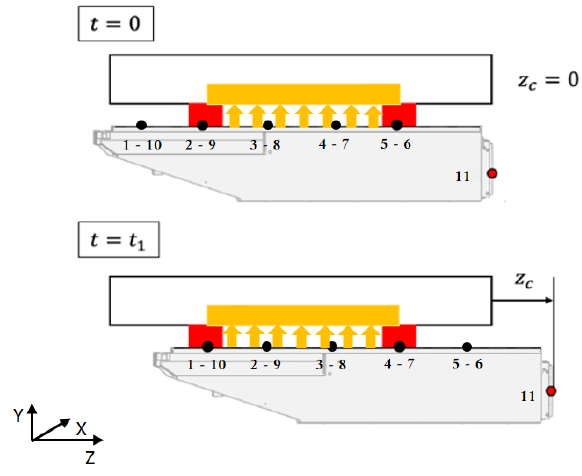
Figure 3. Forces on the nodes changing with time.